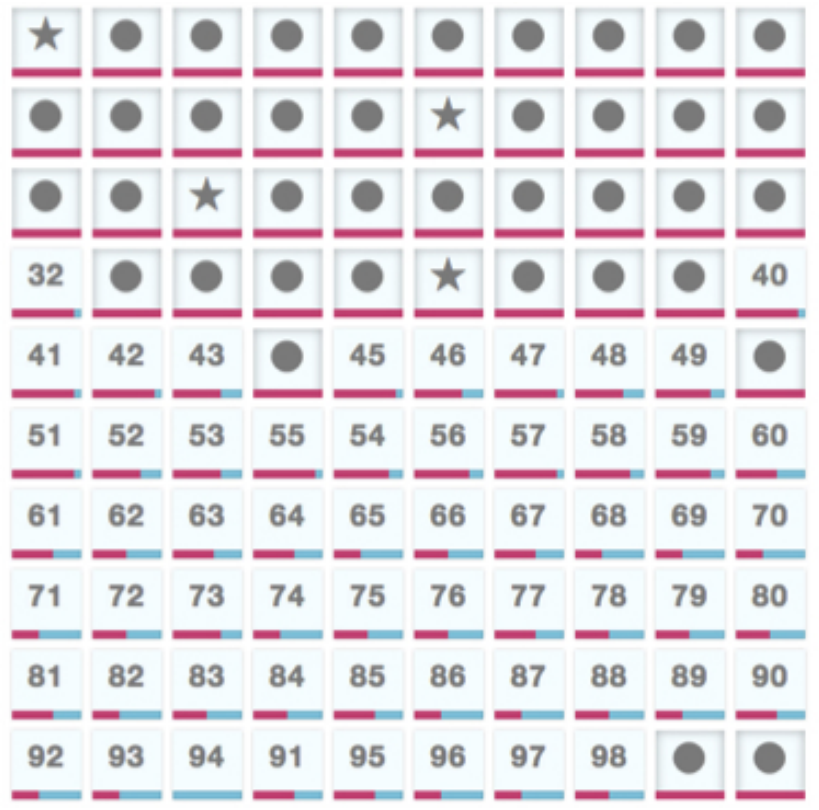
Figure 3. The board selection view. Stars indicate boards the active player has completed, circles indicate boards that have been completed by a sufficient number of different players, and numbers indicate open boards. The pink progress bar indicates how close the community is to finishing the